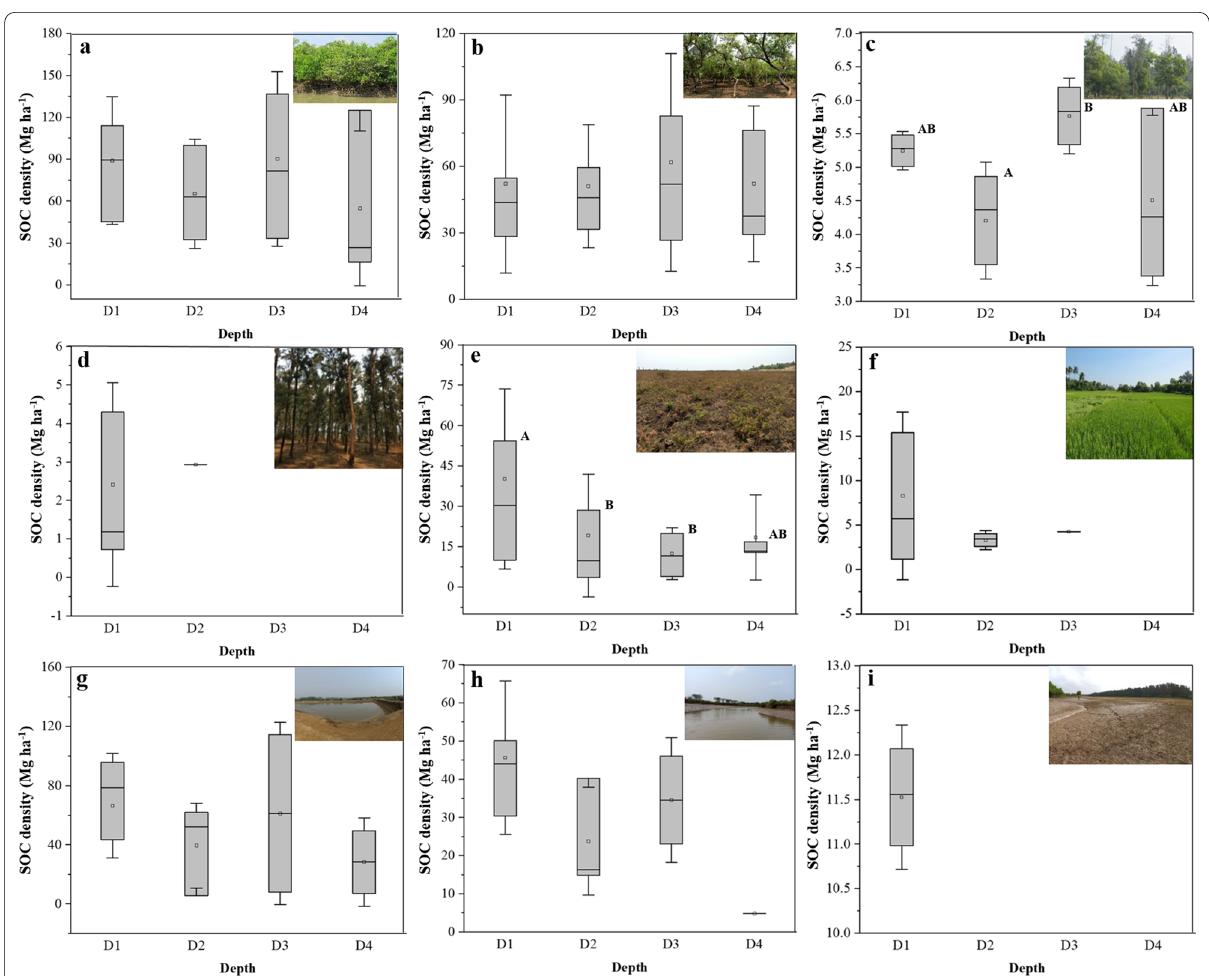
Fig. 6 SOC densities of the four core-depth intervals under different LULC categories. a dense mangrove; b open mangrove; c mixed vegetation; d Casuarina plantation; e herbaceous vegetation; f agriculture; g aquaculture; h waterbody; i bare earth and sand. Different superscript letters represent significant differences among core-depth intervals under a particular LULC category according to one-way ANOVA ( F ) followed by Tukey HSD Post Hoc test at p <